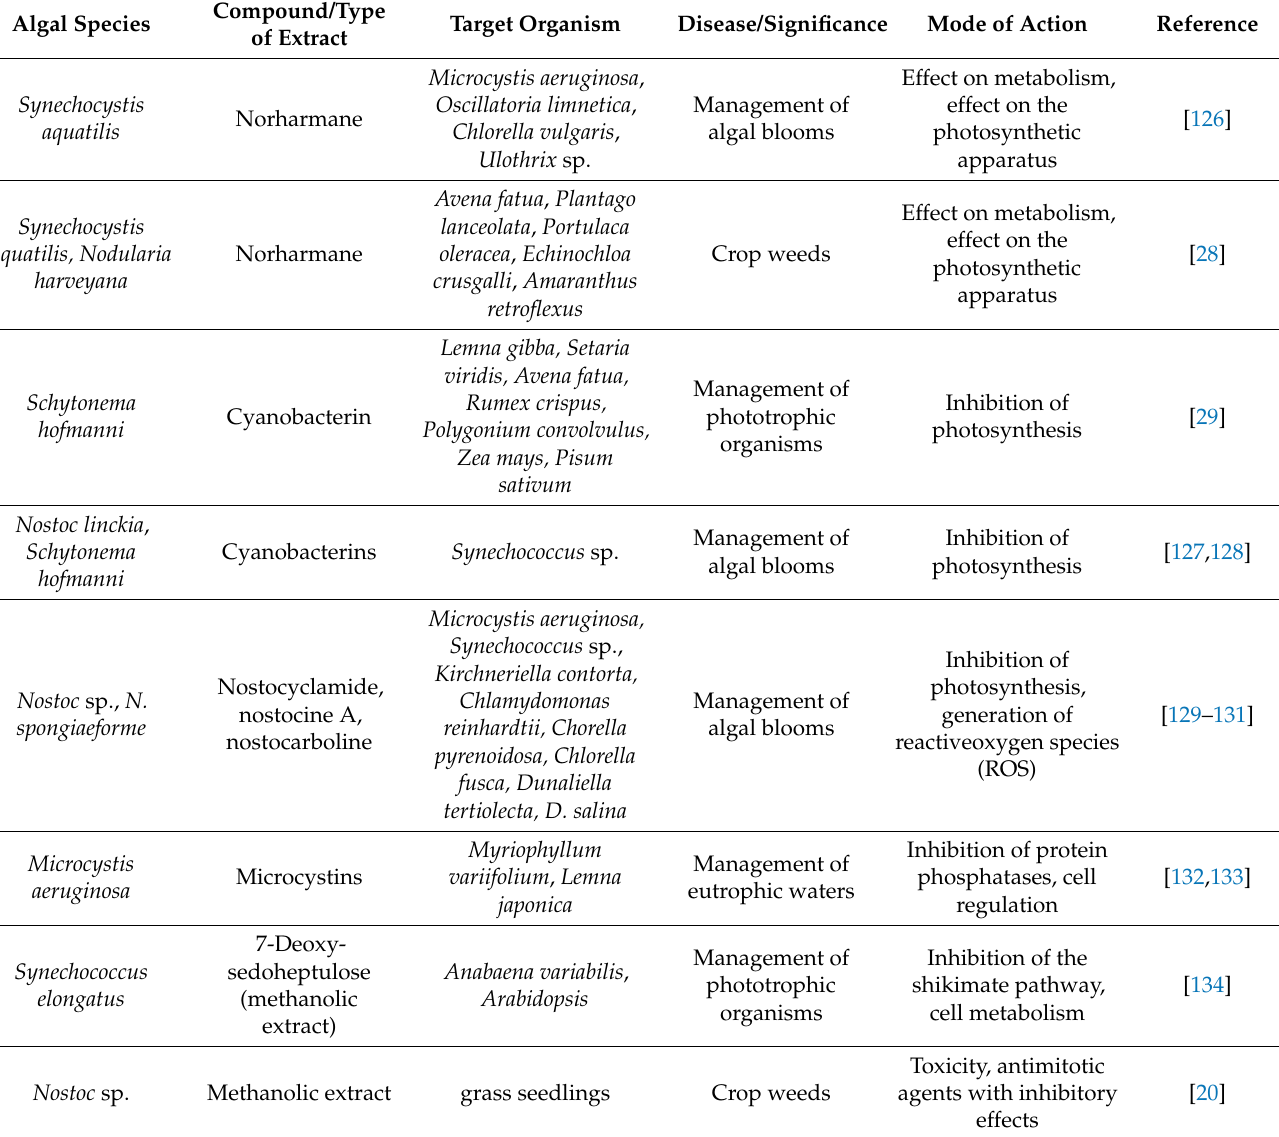
Table 6. Herbicidal activity of algal